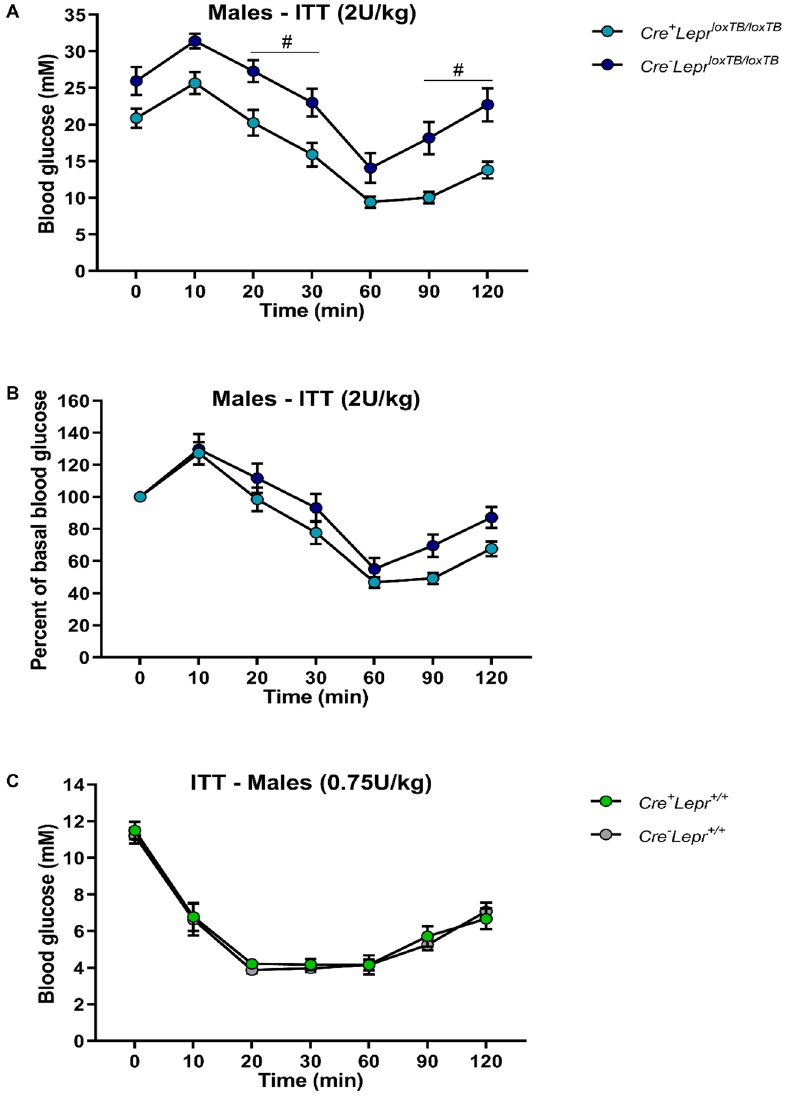
Figure 2. Insulin tolerance tests (ITTs) in male mice from the Lepr reconstitution study. In ( A ), the insulin dose was 2U per kg of body weight. In ( B ), blood glucose concentration of each mouse in ( A ) was normalized to its basal (0 min) blood glucose concentration. In ( C ), the insulin dose was 0.75 U per kg of body weight. In ( A ) and ( B ), n = 18 for Cre + Lepr loxTB/loxTB and n = 14 for Cre − Lepr loxTB/loxTB ; in ( C ), n = 15 for Cre + Lepr + / + and n = 11 for Cre − Lepr + / + . Performed repeated measures two-way ANOVA with post-hoc analysis. # p < 0.05 vs. Cre − Lepr loxTB/loxTB . Main effect of time (p < 0.05) in ( A – C